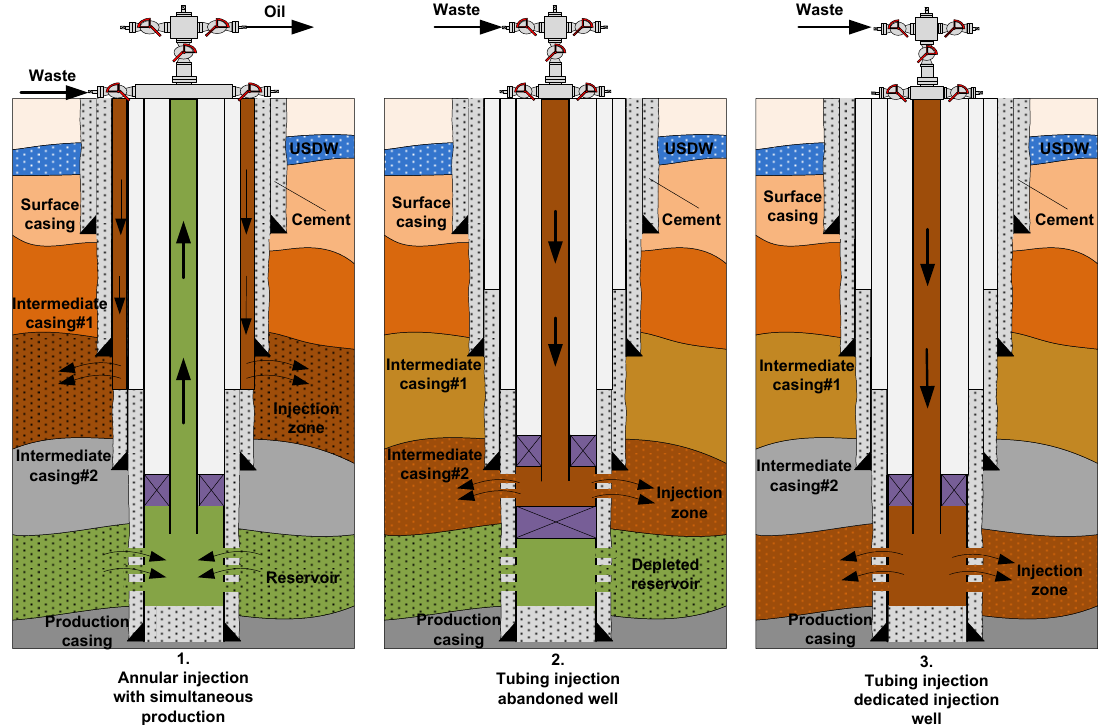
Figure 1. Annular waste injection (1) and tubular injections (2 and 3).